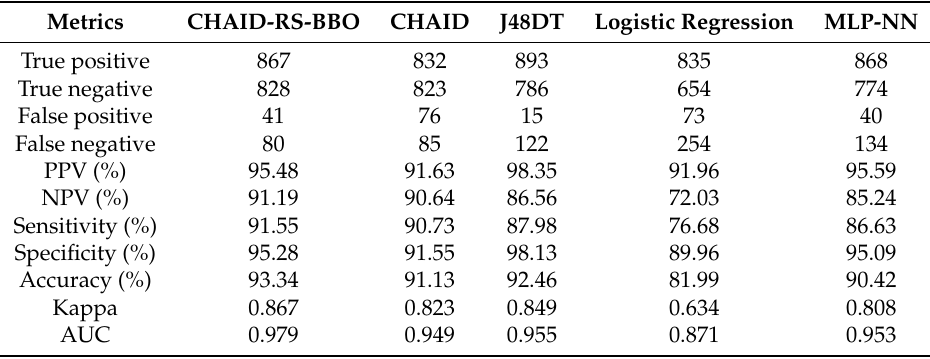
Table 3. Performance of the flash flood models in the training phase.